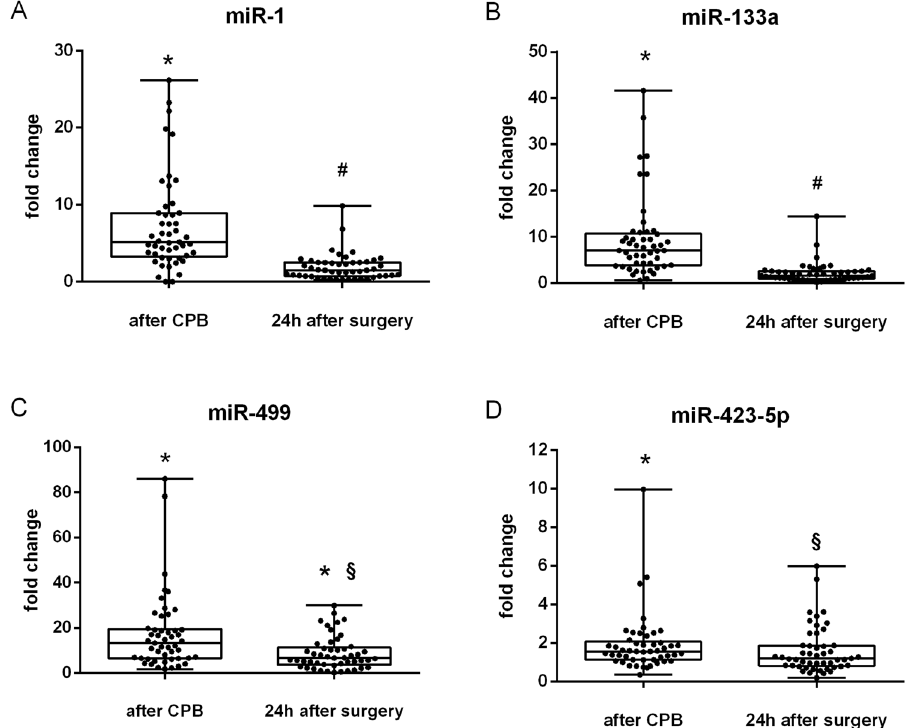
Figure 2. Plasma expression of miR-1, miR-133a, miR-499, and miR-423-5p after CABG. Expression fold change of plasma miR-1 ( A ), miR-133a ( B ), miR-499 ( C ), and miR-423-5p ( D ) in CABG patients (n = 49) immediately after CPB and 24 h after surgery compared to their baseline before CPB. Expression of miRNA was normalized to cel-miR-54 and is presented as fold change versus before CPB. Data are shown as box-whisker plots with median and all data points. Statistics: Friedman test followed by Dunn’s post hoc test; * P ≤ 0.005 vs. before CPB, # P ≤ 0.005 vs. after CPB, § P ≤ 0.05 vs. after